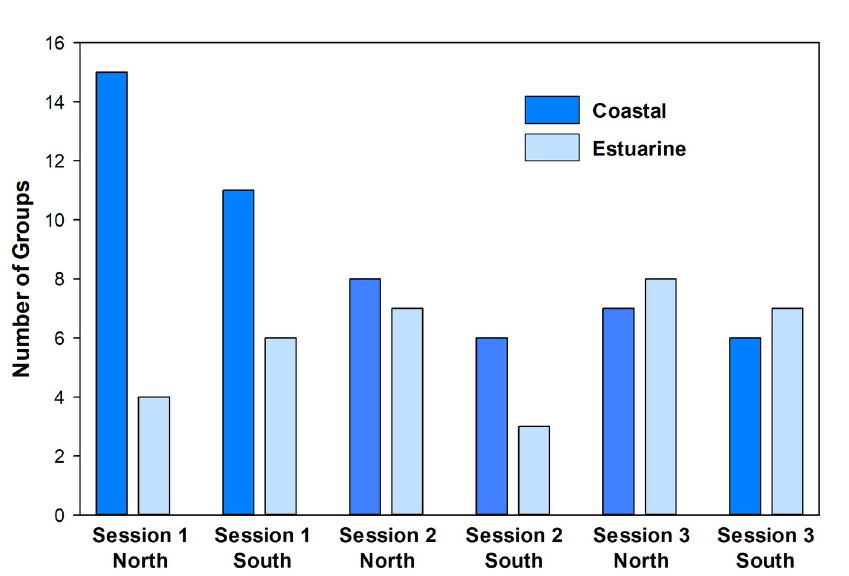
Fig 3. Encounters of dolphin groups during each of three survey sessions by habitat and area. More dolphin groups were encountered during the first of the three photo-ID sessions and during all sessions more sightings occurred north of Cape Fear (North) relative to south of Cape Fear (South). S1, S2 and S3 indicate the session. https://doi.org/10.1371/journal.pone.0270057.g003 ranged from 1–19 sightings over 2–23 years. Of the 228 individuals, 201 were seen within the defined SNCESS winter boundary during the 2018 survey and 93 of those had sighting Table 3. Group and environmental characteristics during the winter 2018 abundance survey for estuarine-resident common bottlenose dolphins in North Carolina. Characteristic Parameter Defined winter boundary Extended survey area Coastal Estuary Coastal Estuary Group Size